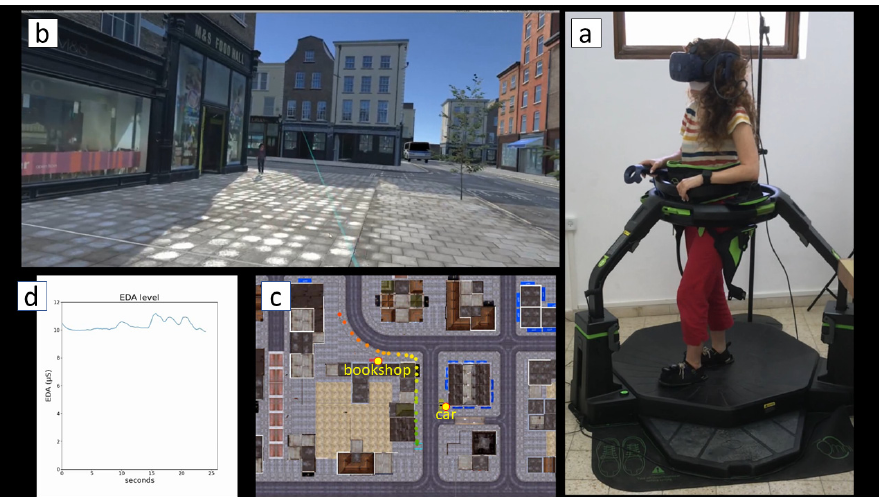
Figure 1. Participant 2 on her 2nd run, 25 s into the experiment. ( a ) The walking posture on the Virtuix Omni treadmill. ( b ) The immersive display. ( c ) The walking route (“GPS” points). The color of points represents time (green tones at beginning of the route and red ones toward the end of the route). ( d ) EDA level along the experiment (x axis—time in seconds since the beginning of the experiment; y axis—electrodermal activity (EDA) level in μ S). See a dynamic representation of Figure 1 in Video S1.